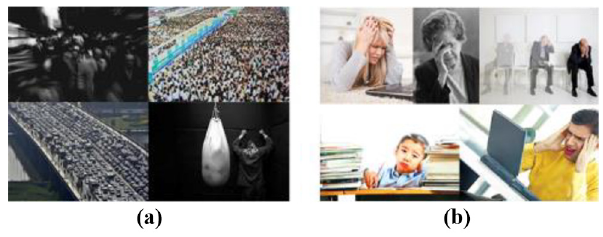
Figure 1 Parts of the anxiety induction